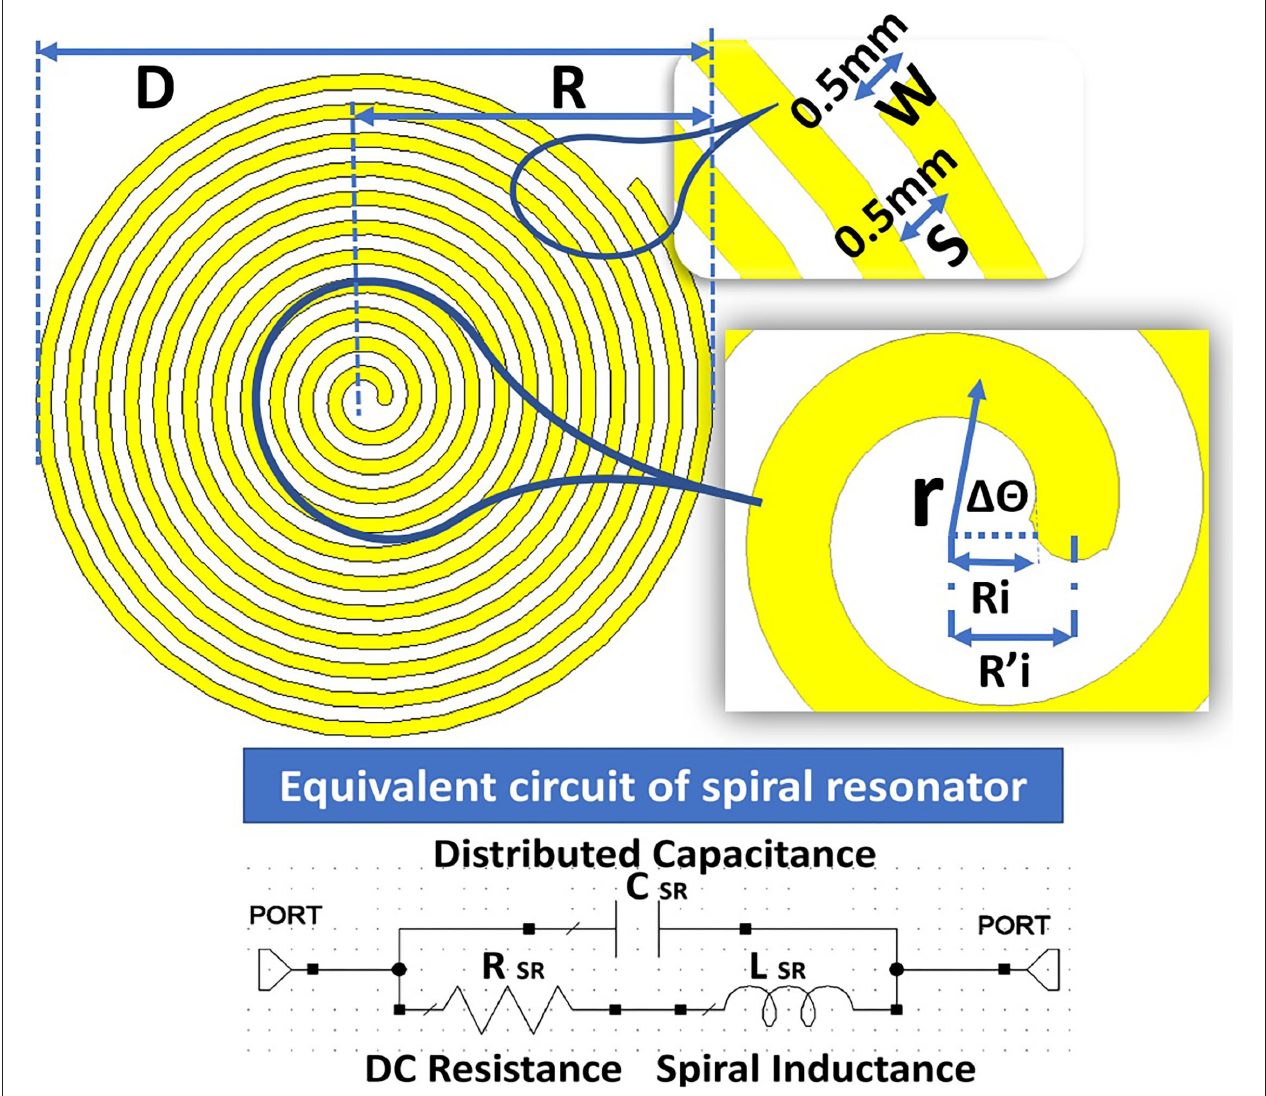
FIGURE 4 | Structure of the spiral resonator (SR) with an equivalent circuit to calculate the distributed